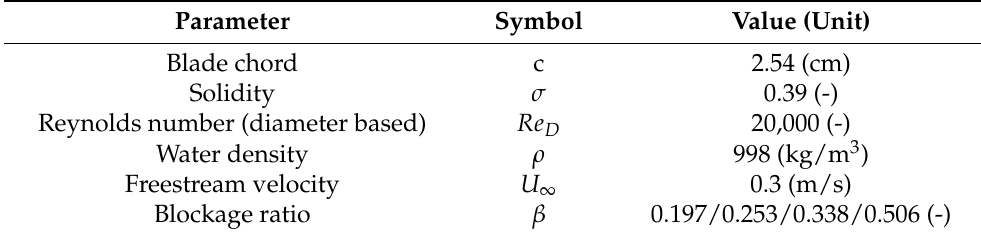
Table 1. Summary of the turbine geometry and relevant